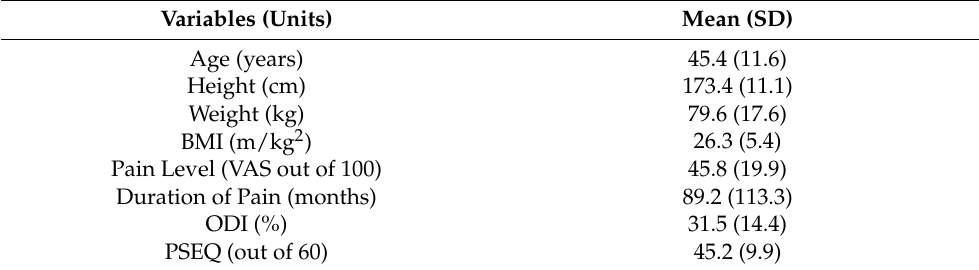
Table 1. Descriptive participants’ demographic